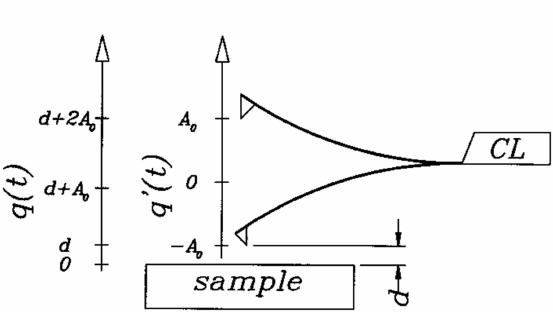
Figure 1. Schematic view of a vibrating cantilever close to a sample, it oscillates with an amplitude A 0 , the closest z -distance is d . Soft cantilevers with a low spring constant k require a large oscillation amplitude to secure a stable oscillation. Adapted with permission by American Physical Society from Figure 1 in